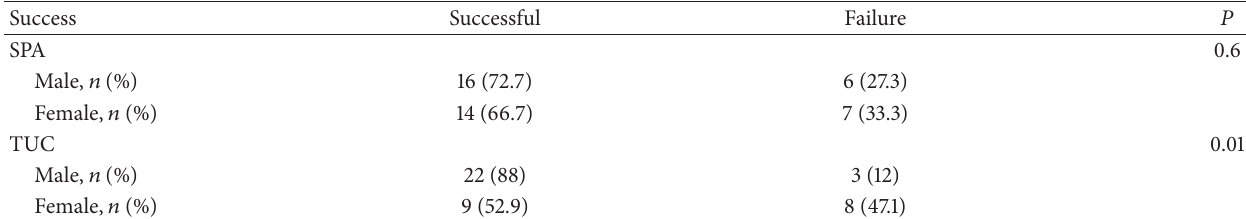
Table 3: Comparison of the success rates of SPA and TUC for male and female